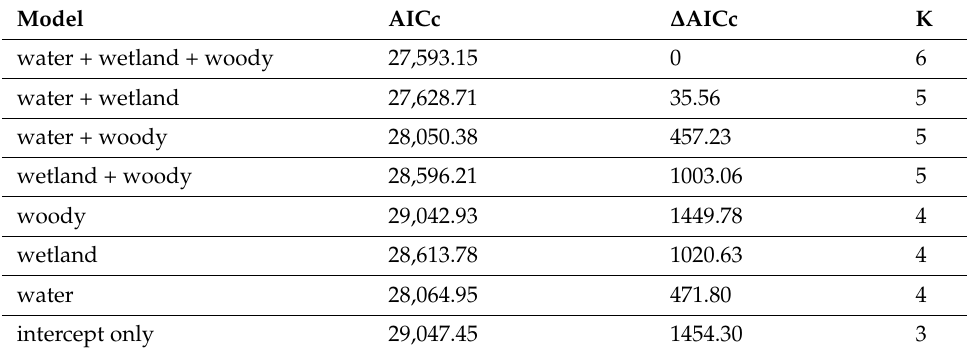
Table 2. Model selection of Gaussian Markov Random Field (GMRF) models for fine-scale habitat selection by American white pelicans at the breeding ground in the Northern Great Plains. Symbols AICc and ∆ AICc stands for Akaike information criterion corrected for small sample size and dif- ferent in AICc between a model and the best model, respectively. Letter K denotes the number of unknown